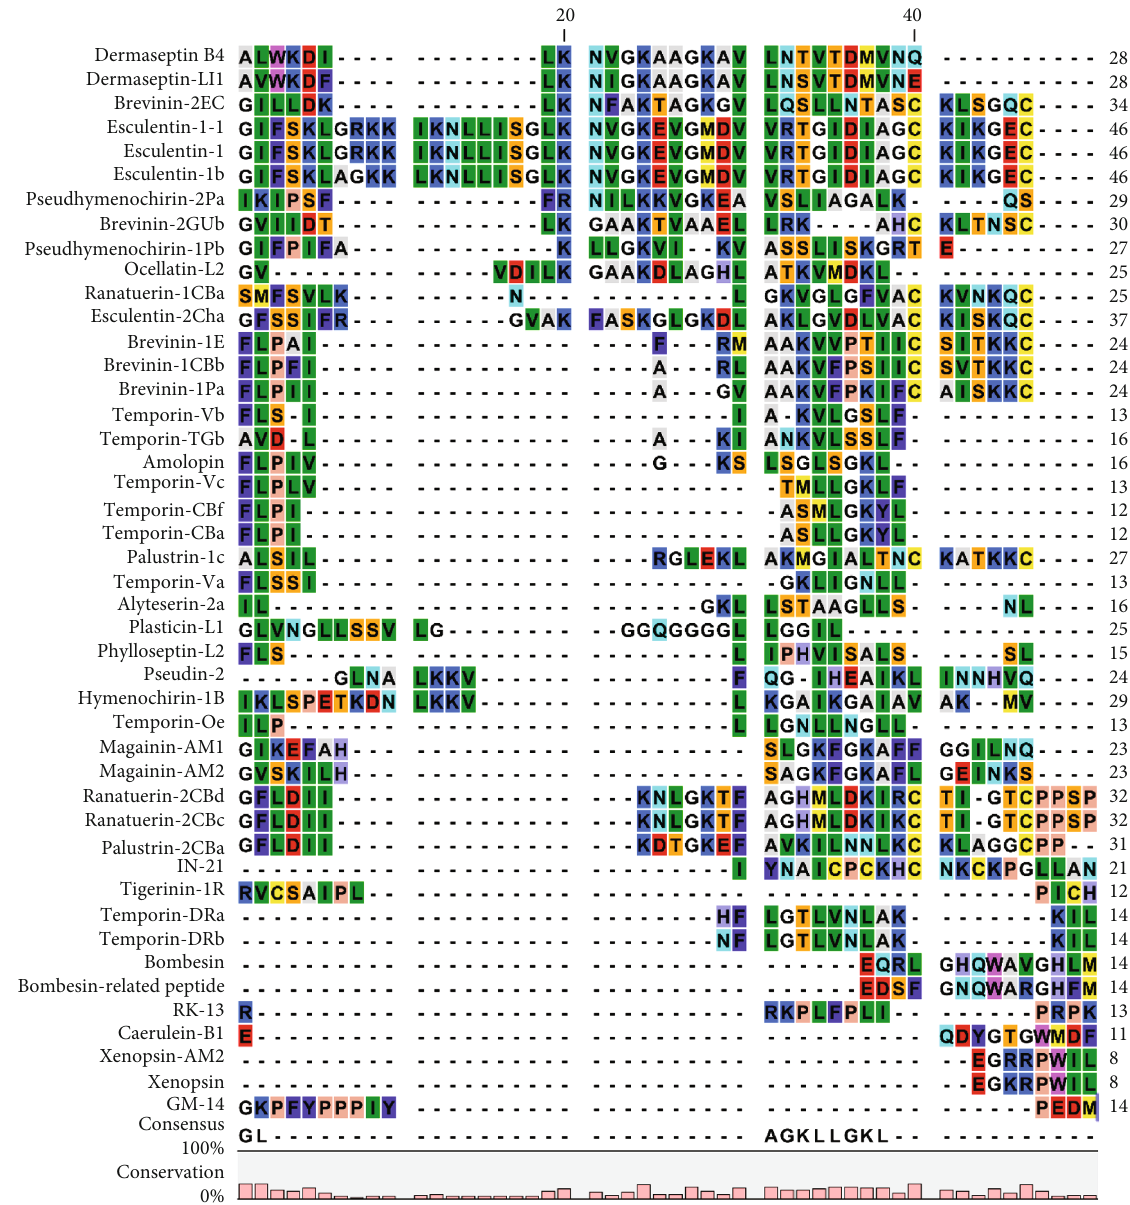
Figure 2: Sequence alignment of reported antidiabetic